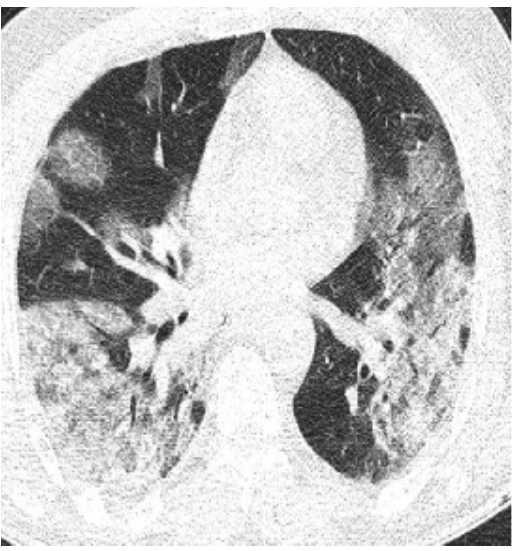
Figure 1 - Covid 19 pneumonic